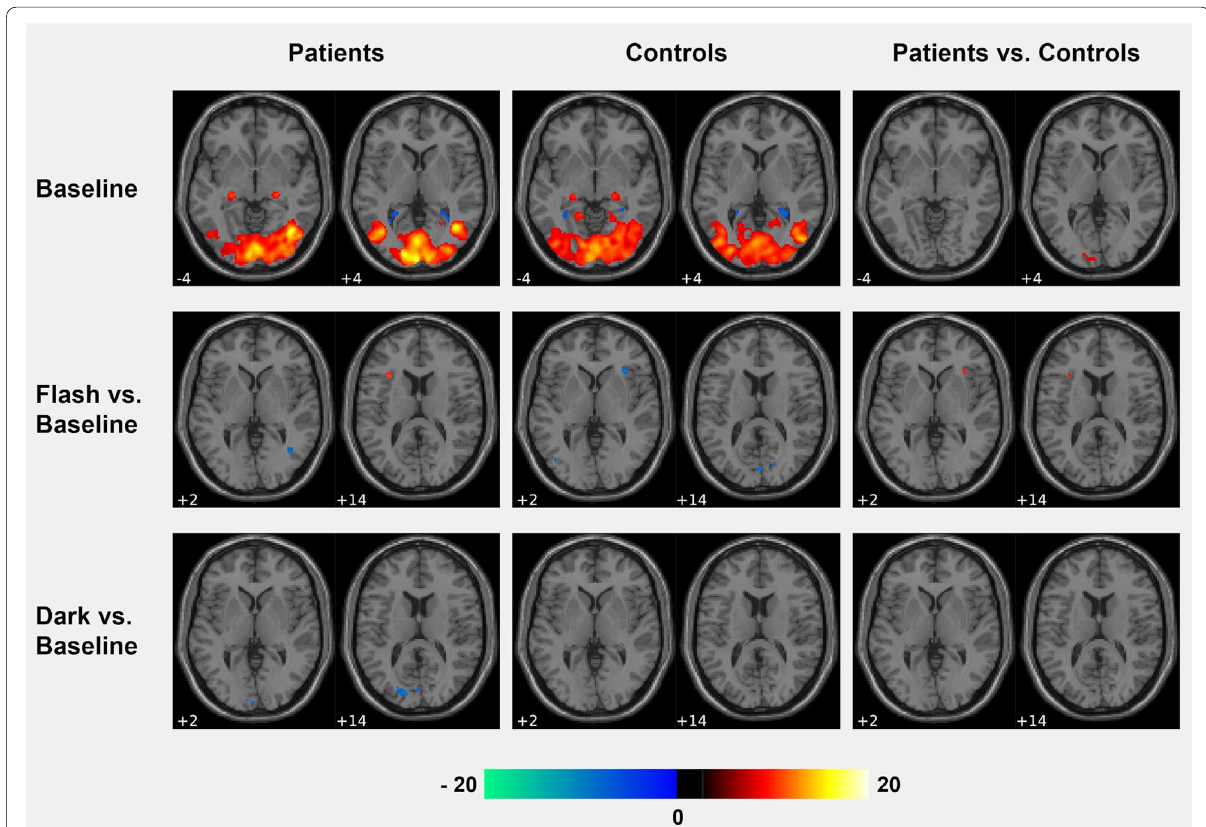
Fig. 3 Functional activation induced by flickering light in patients and controls at baseline, and after Flash and Dark intervention, contrasted to the baseline (FWE 0.05 corr., cluster threshold 10). At baseline, patients display higher activation in the primary visual cortex than controls. When = contrasting Flash vs. baseline, patients show higher activation in the bilateral anterior insula compared to controls, while no difference was found for the contrast Dark vs.